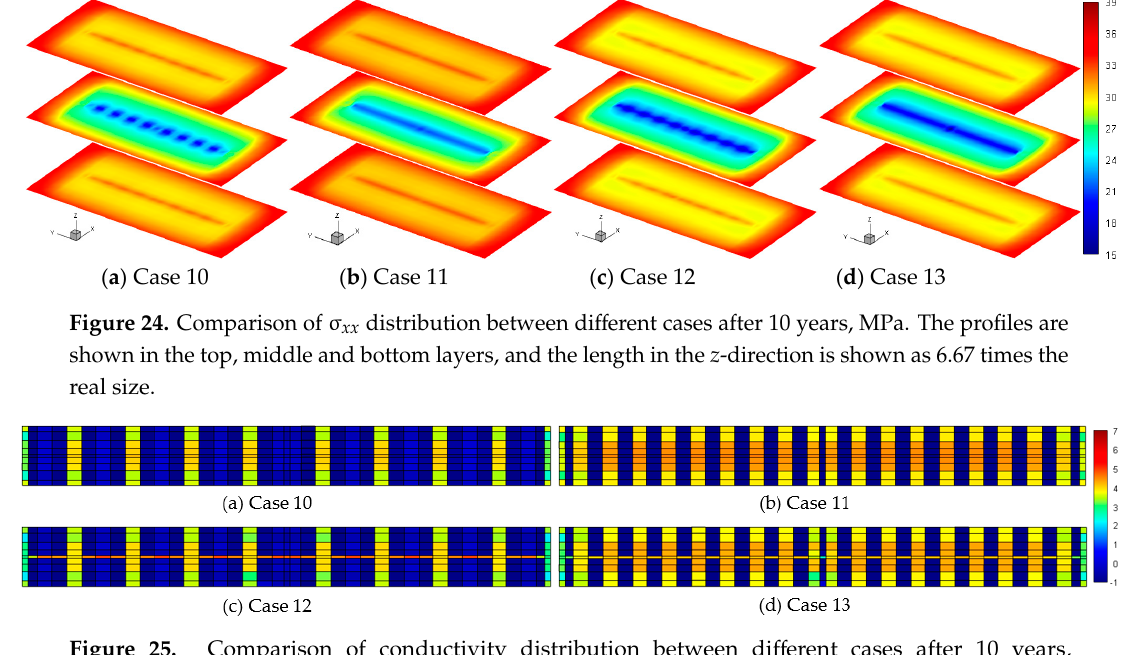
Figure 23. Four fracture profiles with different proppant distributions (gray: propped; white: